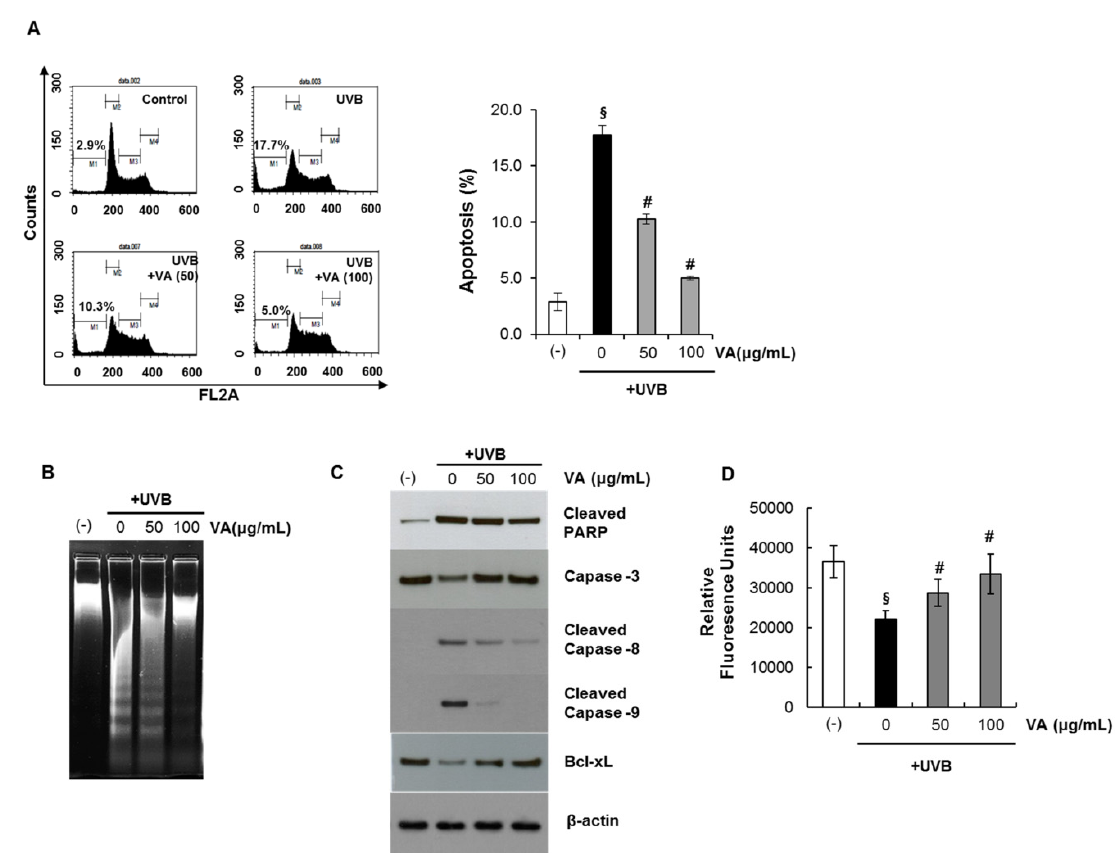
Figure 5. Inhibitory effect of veratric acid on UVB-induced apoptosis. ( A ) The percentage of apoptotic cells. ( B ) Agarose gel electrophoresis of nuclear DNA fragments. ( C ) Immunoblot analysis of various apoptosis related proteins. ( D ) Intracellular GSH